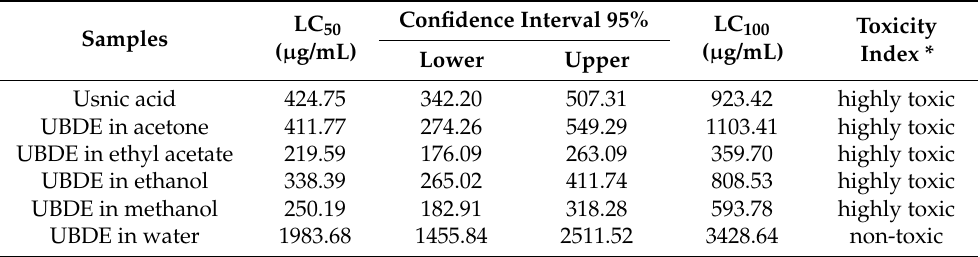
Table 7. The BSL assay results (LC 50 and LC 100 ) and toxicity evaluation of usnic acid and UBDE tested in 24 h exposure.